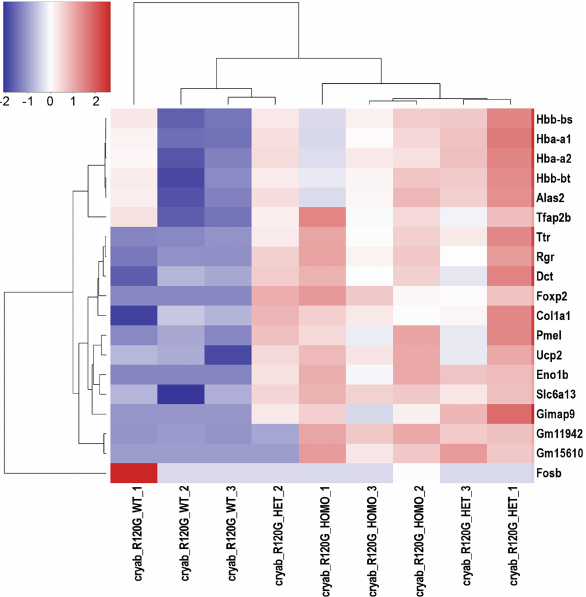
Fig 4. Heat maps of genes with altered expression in Cryab -R120G knock-in mutant lenses as displayed by the R package heatmap3 [31]. In order to illustrate relative log 2 fold-changes across samples, the values displayedper gene represent log 2 transformed counts-per-million with a prior count of 2, which were then rescaledto a mean of 0 with a standarddeviationof 1. The genes and sampleswere then re- organized by hierarchicalclusteringto illustrate the similarity of expressionchangeswithin and across